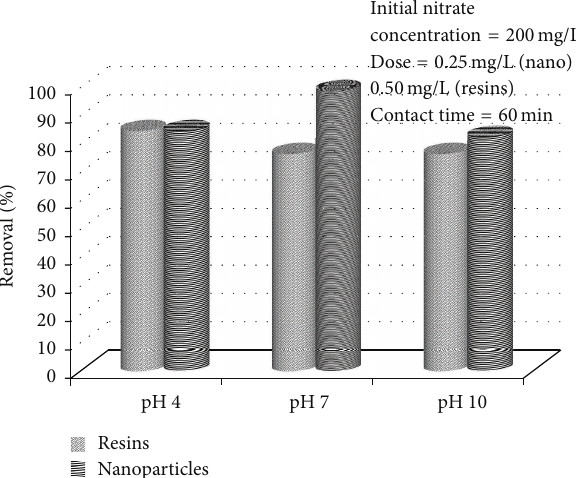
Figure 3: Effect of pH on nitrate removal by resins and Fe/Pt bimetallic nanoparticles.